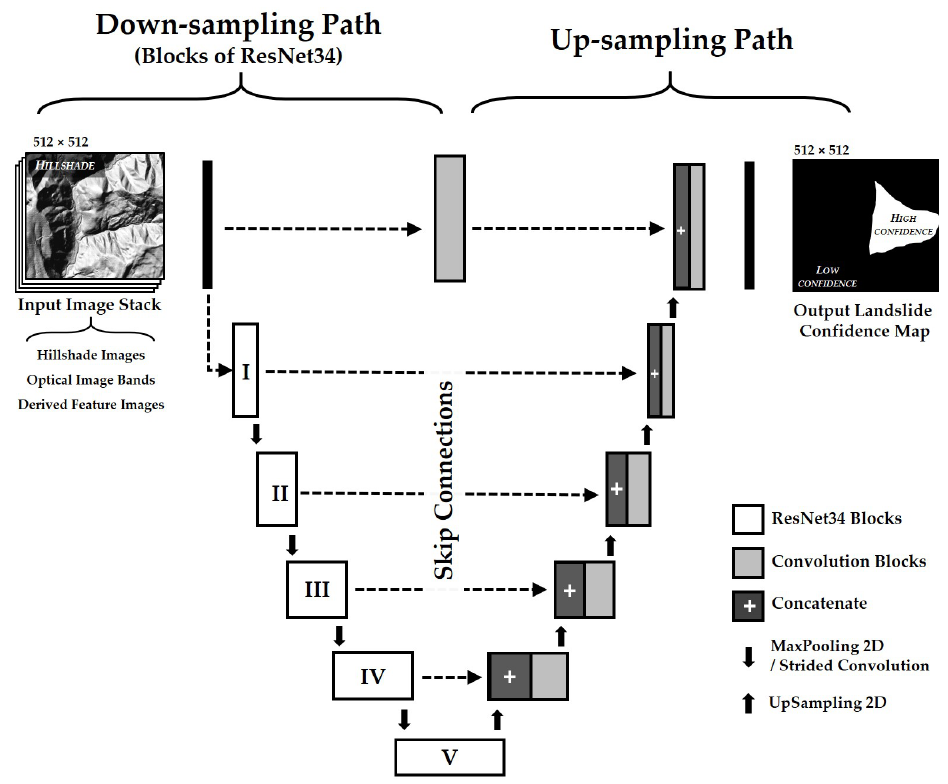
Figure 2. U-net architecture with ResNet34 blocks in the down-sampling